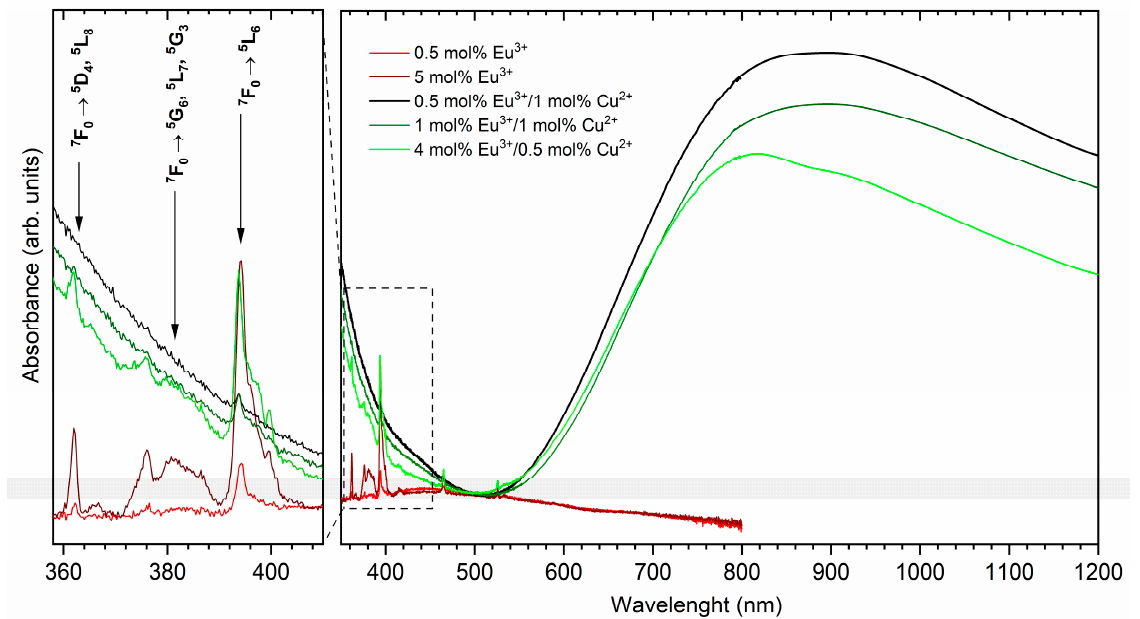
Figure 5. The absorption spectra of the Eu 3+ -doped and Eu 3+ /Cu 2+ -co-doped Ca 10 (PO 4 ) 6 (OH) 2 . The excitation emission spectra, which were recorded at room temperature by mon- itoring the intense red emission at 618 nm ( 5 D 0 → 7 F 2 ), of investigated materials are pre- sented in Figure 6. The representative excitation spectra of the 1 mol% Eu 3+ :HAp and 1 mol% Eu 3+ /1 mol% Cu 2+ :HAp are presented. As demonstrated, the excitation spectra con- sisted of visible intra-configurational 4f-4f transitions with sharp lines characteristic of Eu 3+ ions. Particularly, these narrow bands located at around 320, 363, 383, 395, 416, and 466 nm originated from the 7 F 0 → 5 H J ; 7 F 0 → 5 D 4 , 5 L 8 ; 7 F 0 → G 2 , 5 L 7 , 5 G 3 ; 7 F 0 → 5 L 6 ; 7 F 0 → 5 D 3 transitions of Eu 3+ ions, respectively [31,35]. The absorption peak of the 7 F 0 → 5 H J transition at 320 nm indicates that the energy band-gap of HAp is considerably larger than that in, e.g., Eu 2 Ti 2 O 7 oxide [42], in which the 5 H 3,6 -related transition peak is completely masked by the charge transfer band due to its lower energy band-gap nature. The f-f electron tran- sitions are weakly affected by the crystal field; thus, their positions remain almost steady due to good isolations of lanthanide’s f orbitals by an external shell [19,31,43]. As can be seen, the intensity of the emission excitation spectra is much lower in the case of the co- doped material than in that single doped with Eu 3+ in the HAp host.